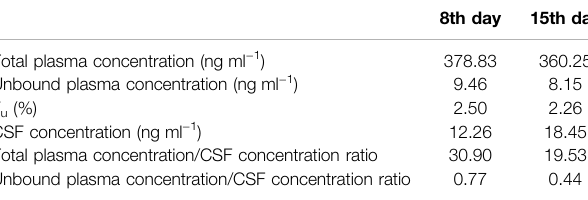
8th day 15th day